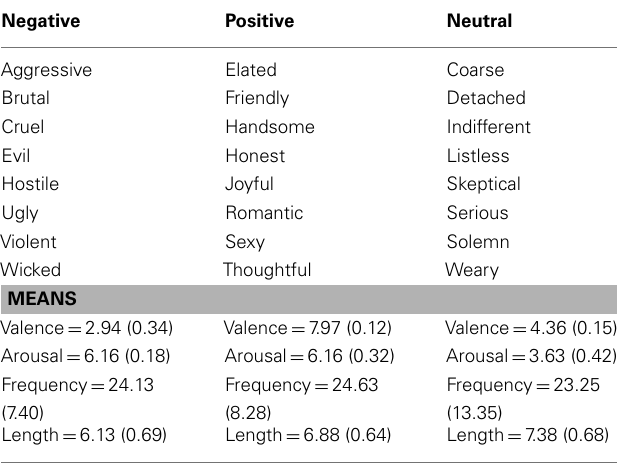
Table 1 | Negative, positive, and neutral words used as distracter items, selected from theANEW